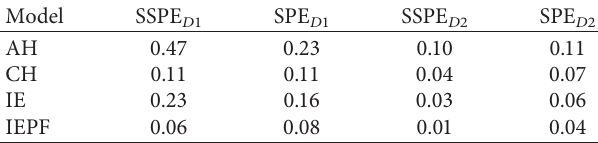
Table 19: Stability of each model for example 4. Model